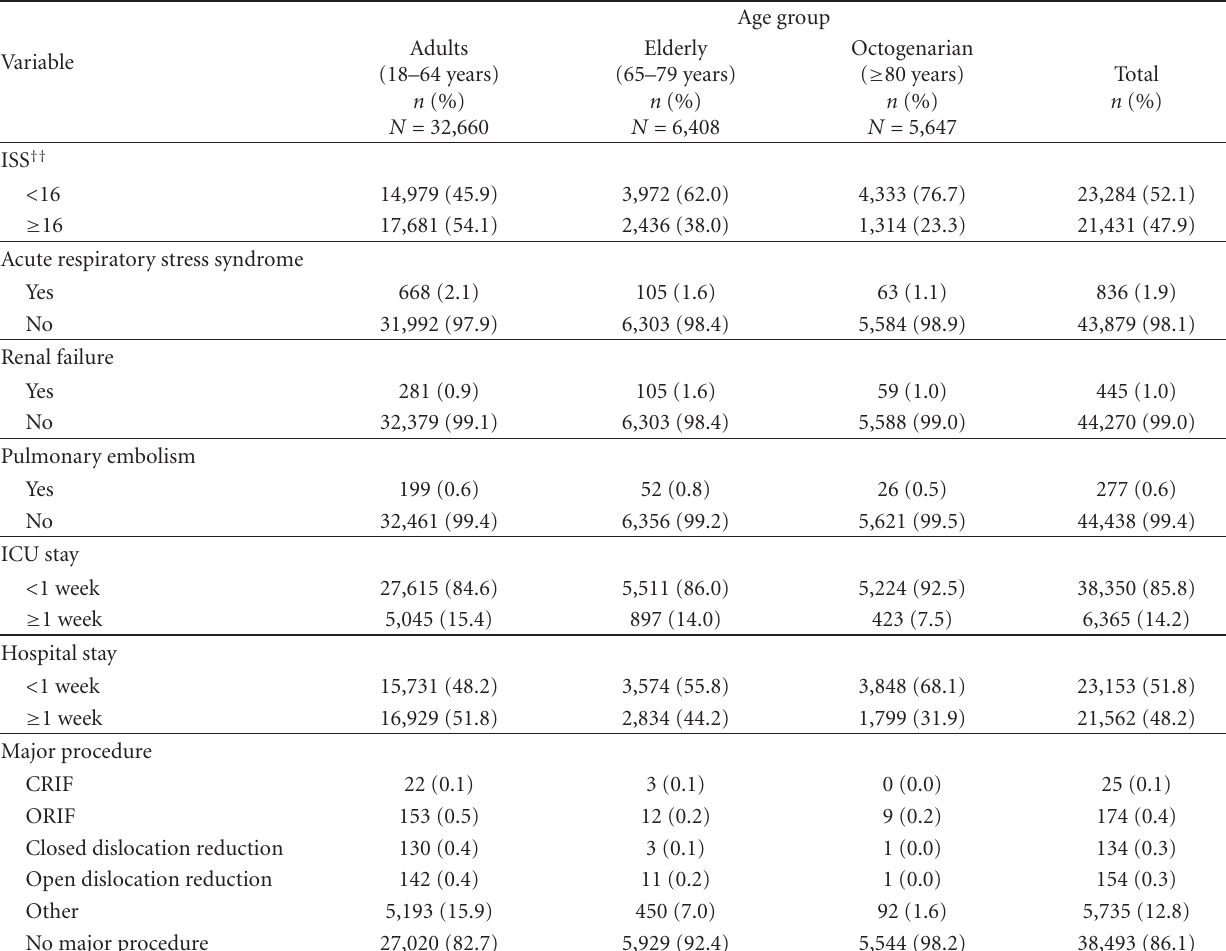
Most of the pelvic fractures were closed (96.4%). How- ever, open fractures occurred in 4.5% of adults and only 0.7% of octogenarian patients. Pubic rami fractures had the highest prevalence (42.7%), with the octogenarian patients having the highest percentage (48%) relative to the elderly (44.7%) and adults (41.4%). The most common known mechanism of injury was motor vehicle accident (34.8%), with low-energy fall (15.6%) and high-energy fall (10.8%) following. As expected, the octogenarian patients had a high rate of low energy falls (49.6%) relative the elderly (32.6%) and adult (6.3%) patients. A large percentage of the population had no mechanism of injury reported